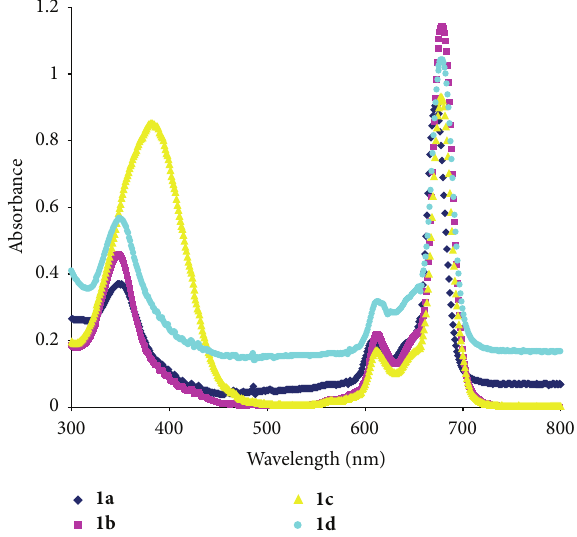
Figure 1: UV-Vis absorption spectra of complex 1a–1d in